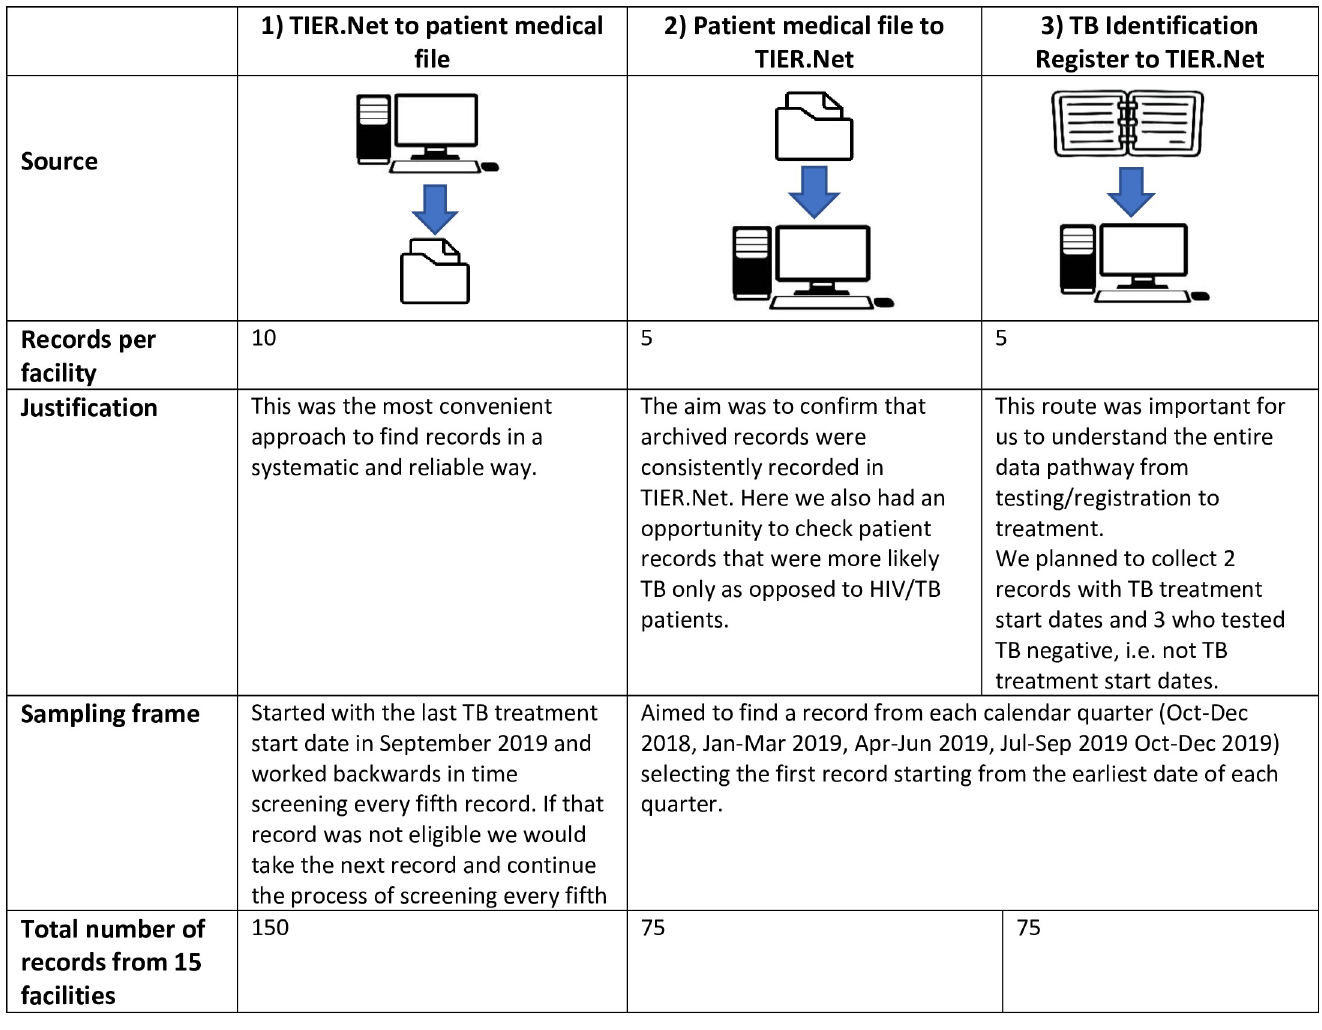
Fig 1. Record targets and route of